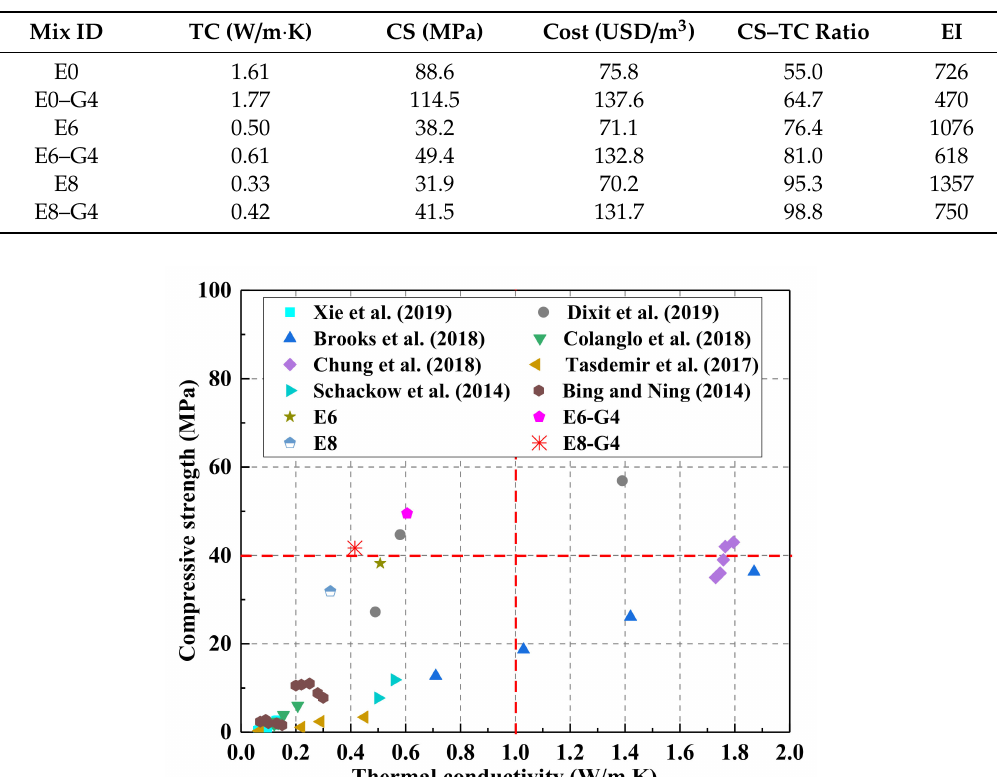
Table 7. Ratios of compressive strength to thermal conductivity and EI calculations of the composites.